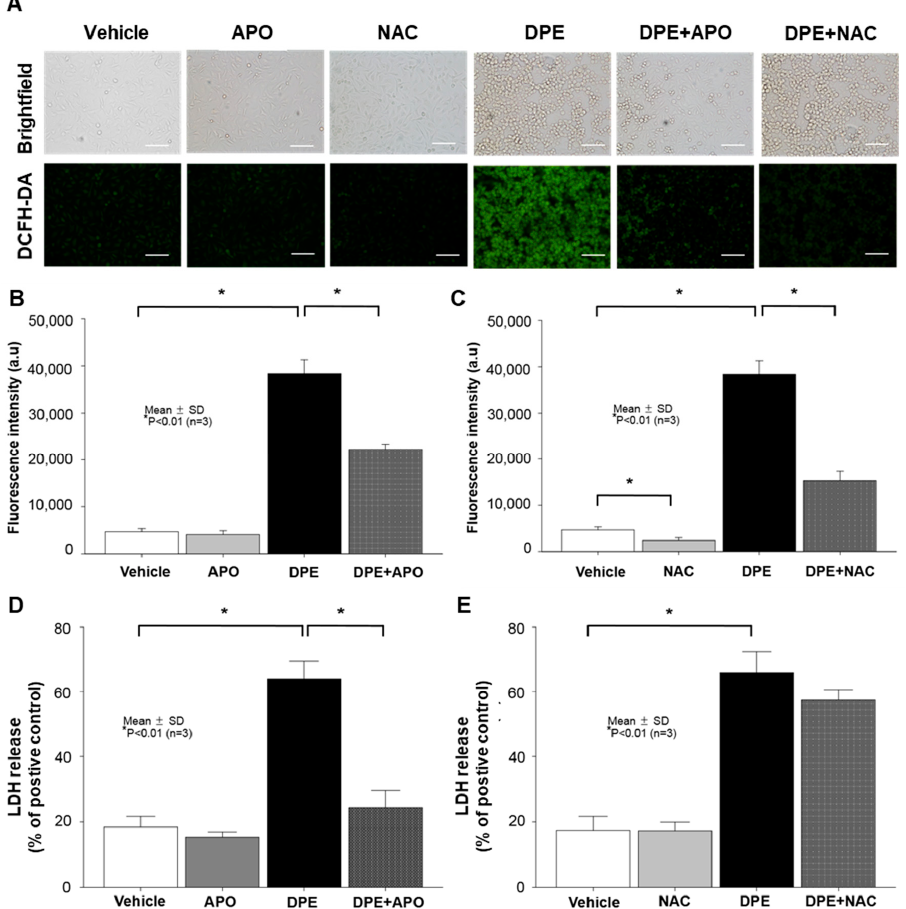
Figure 2. DPE-induced KC apoptosis through activation of NADPH oxidases (NOXs), but not through ROS-dependent pathways. Human KC pre-treated with or without NOX (Apocynin [APO], 100 µ M) or ROS generation (N-Acetylcysteine [NAC], 1 mM) inhibitors for 30 mins were incubated with DPE (100 μ g/mL) for 24 hrs. Intercellular ROS production was determined by either a fluorescence microscopy ( A ) or fluorospectrophotometer ( B , C ) with the oxidant-sensing probe 2 (cid:48) ,7 (cid:48) -dichlorodihydrofluorescein diacetate (DCFH-DA). Cell cytotoxicity was measured by an LDH assay and results were expressed as LDH release compared to the positive control consisting of 0.1% SDS (yielding 100% LDH release) ( D , E ). All values are mean ± SD ( n = 3). Statistical significance was calculated using the unpaired Student’s t -test, and significance was defined as p < 0.01 vs. vehicle control (or untreated control). Bar = 500 µ